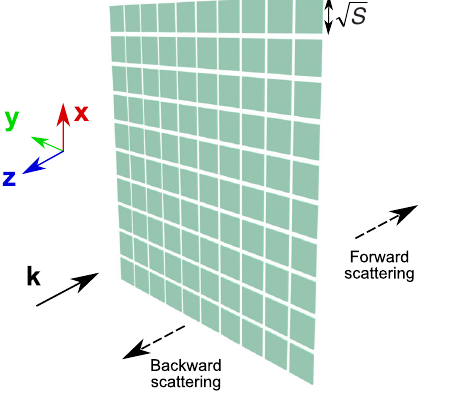
FIG. 1. A schematic illustration of a generic, electrically thin